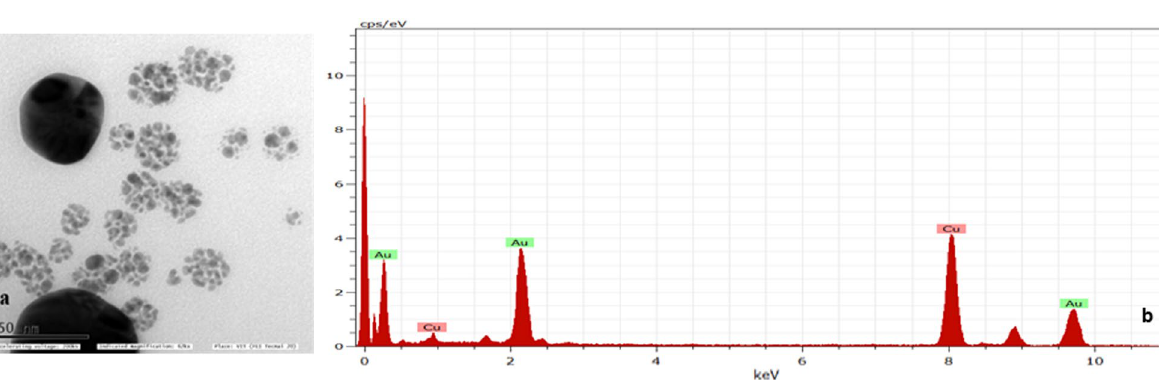
Figure 4. Microscopic and spectroscopic analysis of AuNPs. ( a ) Transmission Electron Micrograph (TEM) of AuNPs. ( b ) Energy Dispersive X-ray (EDX) spectroscopic analysis of synthesized